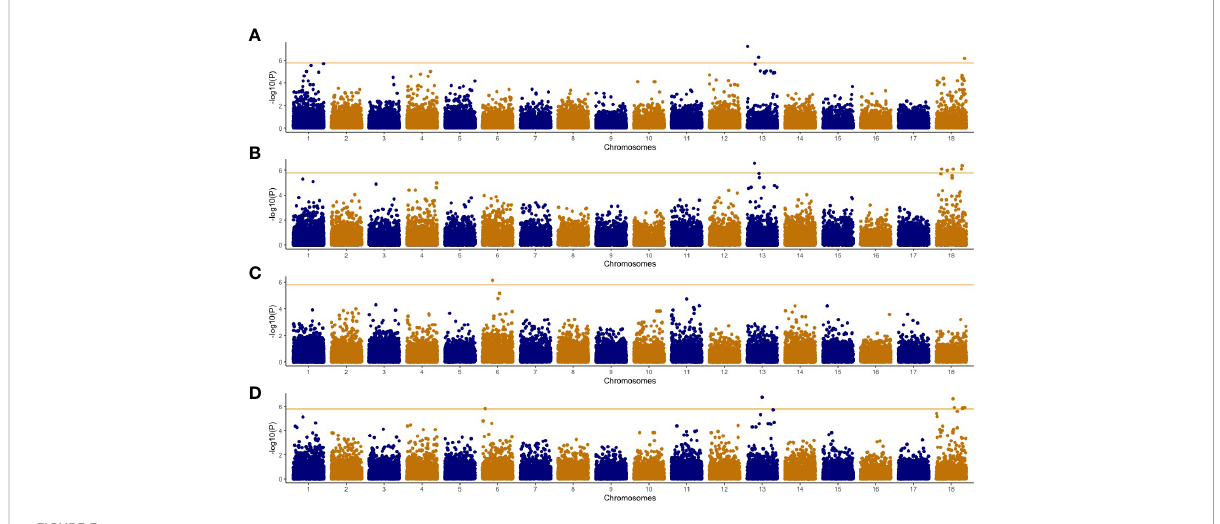
FIGURE 3 Manhattan plots of multivariate genome-wide association studies for CBSD severity trait combinations in the C2 population. A = cassava brown streak foliar severity at 3 and 6 MAP; B = cassava brown streak severity at 3 and 12 MAP; C = cassava brown streak severity at 6 and 12 MAP; D = cassava brown streak severity at 3, 6 and 12 MAP. Orange horizontal line indicates Bonferroni genome wide signi fi cance level [-log 10 (0.05/ number of